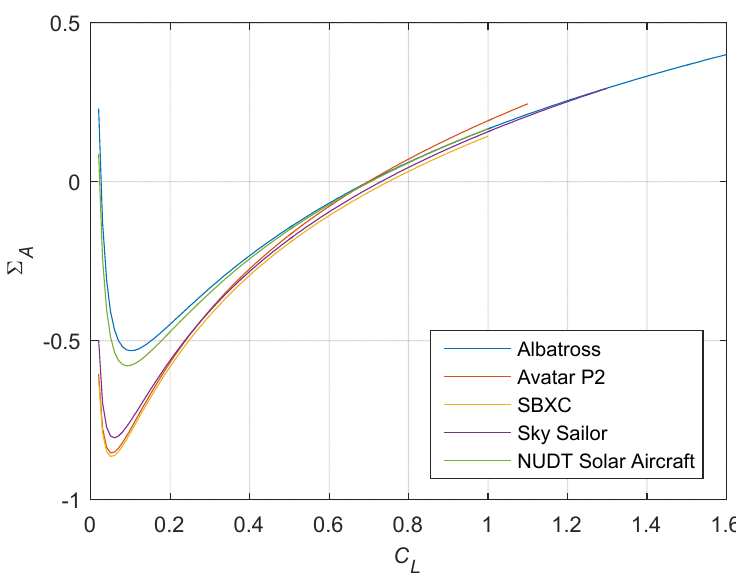
Figure 8. Logarithm of the aerodynamic fraction Σ A with respect to C L for different aircrafts.